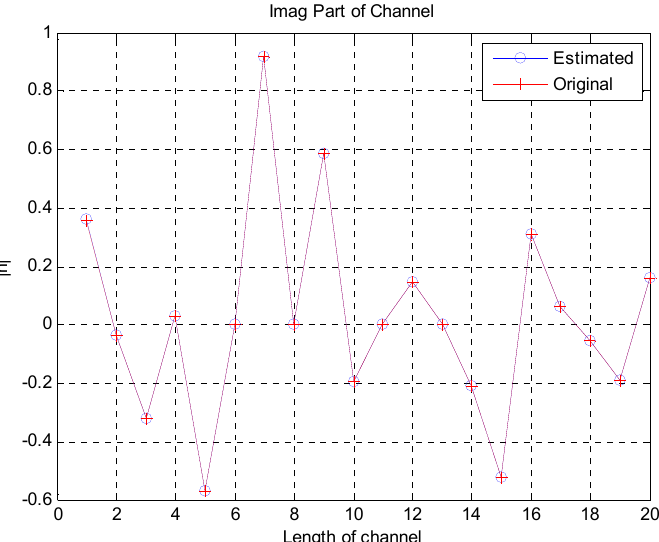
Figure 3. Amplitude estimation of the imaginary part of channel taps.